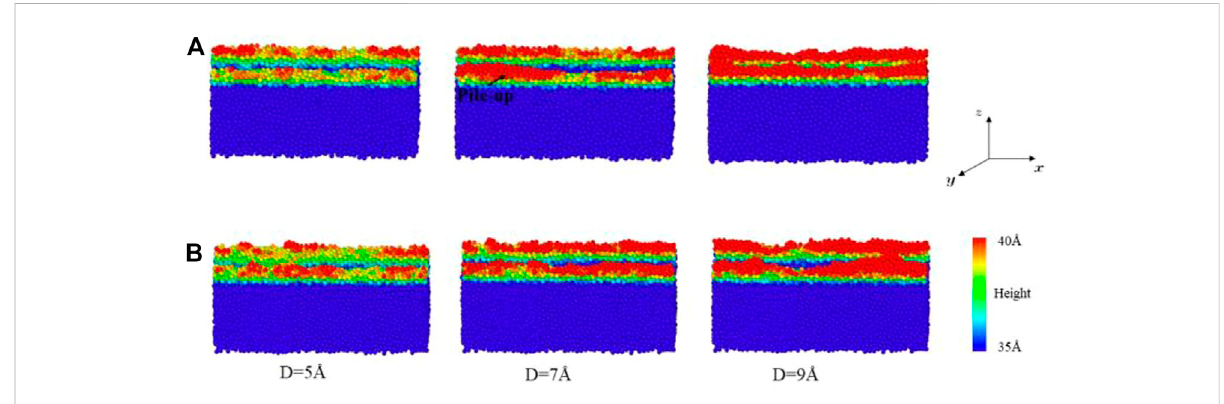
FIGURE 7 Scratched surfaces showing pile-up atoms at a time of 400 ps with a velocity of 1.0A/ps: (A) pure Fe-based model; (B) 15 wt% Al 2 O 3 /Fe amorphous composite model. (Atoms are colored according to height).